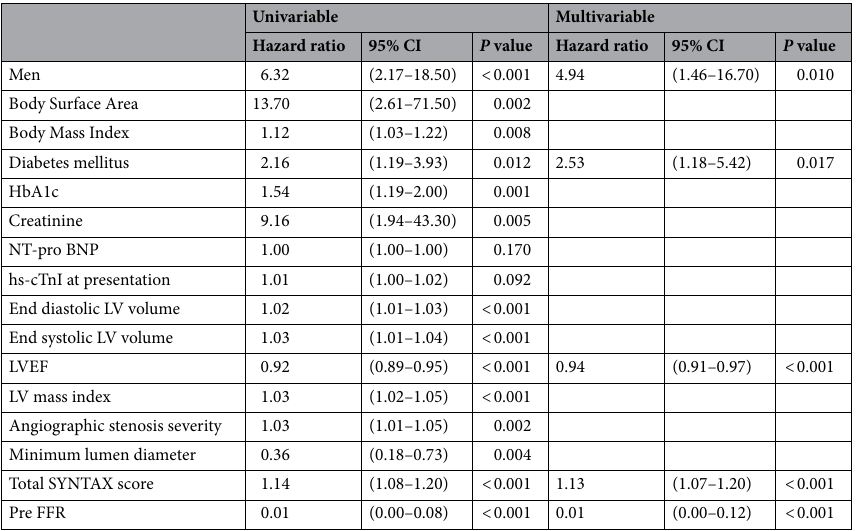
Table 2. Predictors of unrecognized myocardial infarction (Logistic regression analysis). Abbreviations are in Table 1. CI confidence interval.